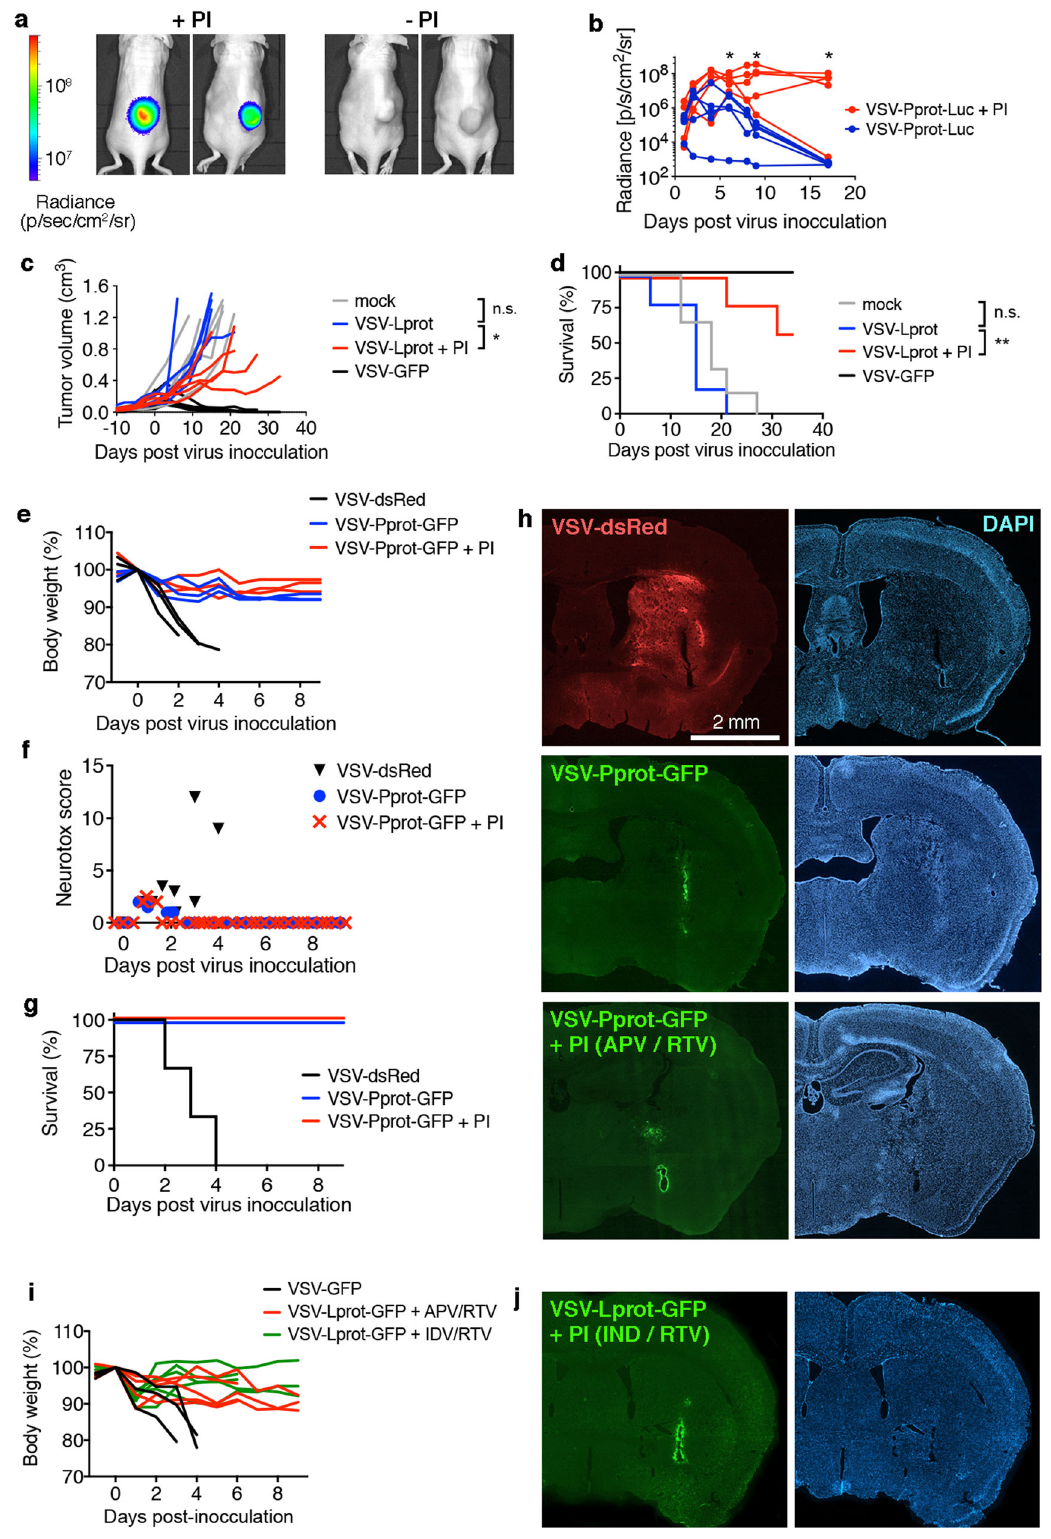
tumors treated with a single injection of VSV-GFP or VSV-Prot- OFF with or without PI co-treatment were harvested at 3, 7, and 10 days post virus inoculation. Histological analysis of VSV-Prot- OFF infected tumors revealed intratumoral spread, although diminished relative to wild-type VSV (Fig. 3h, i), suggesting that VSV-Prot-OFF is attenuated to some extent in vivo. In